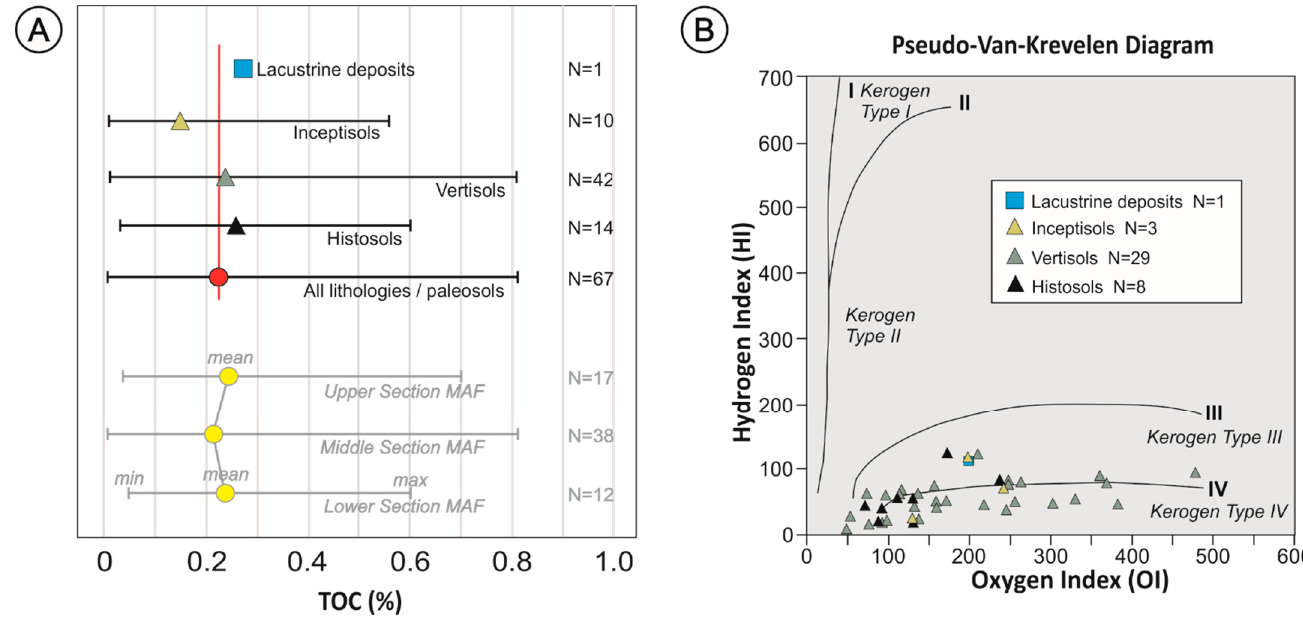
Figure 3. ( A ) TOC content (incl. mean, min. and max.) of the different paleosols and the lacustrine deposits of the Mata Amarilla Formation. Red line corresponds to the average TOC value of all analyzed lithologies. Lower part of diagram shows TOC content (incl. mean, min. and max.) of the different lithostratigraphic intervals. ( B ) Pseudo-Van-Krevelen Diagram (HI = mg HC/g TOC), vs. OI = mg CO 2 /g TOC) showing a total of 39 samples with TOC values > 0.11 wt. % and OI values < 500, in order to illustrate the kerogen types obtained from the different paleosols and lithologies.